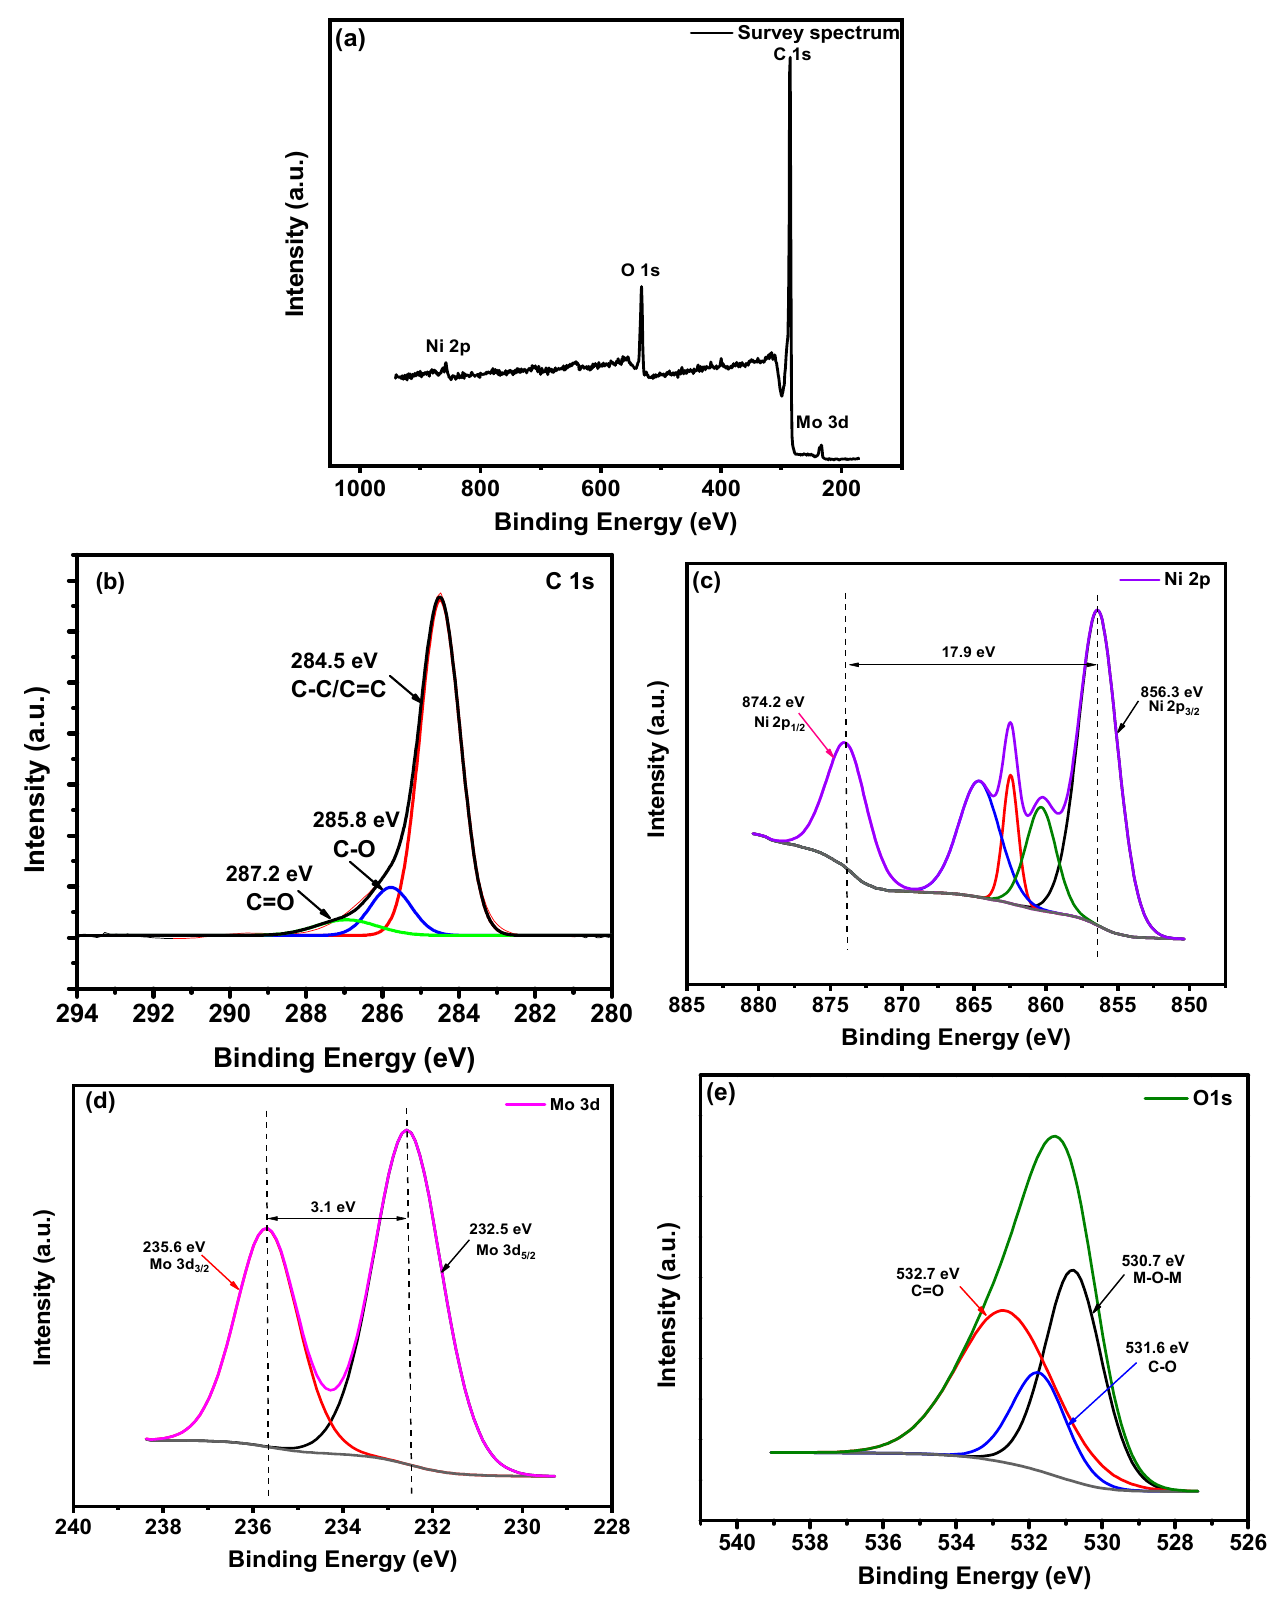
Figure 4. XPS spectra of NiMo3/AC: ( a ) survey spectrum; ( b – e ) core-level spectra ( b ) C 1s, ( c ) Mo 3d, ( d ) Ni 2p, and ( e ) O 1s.